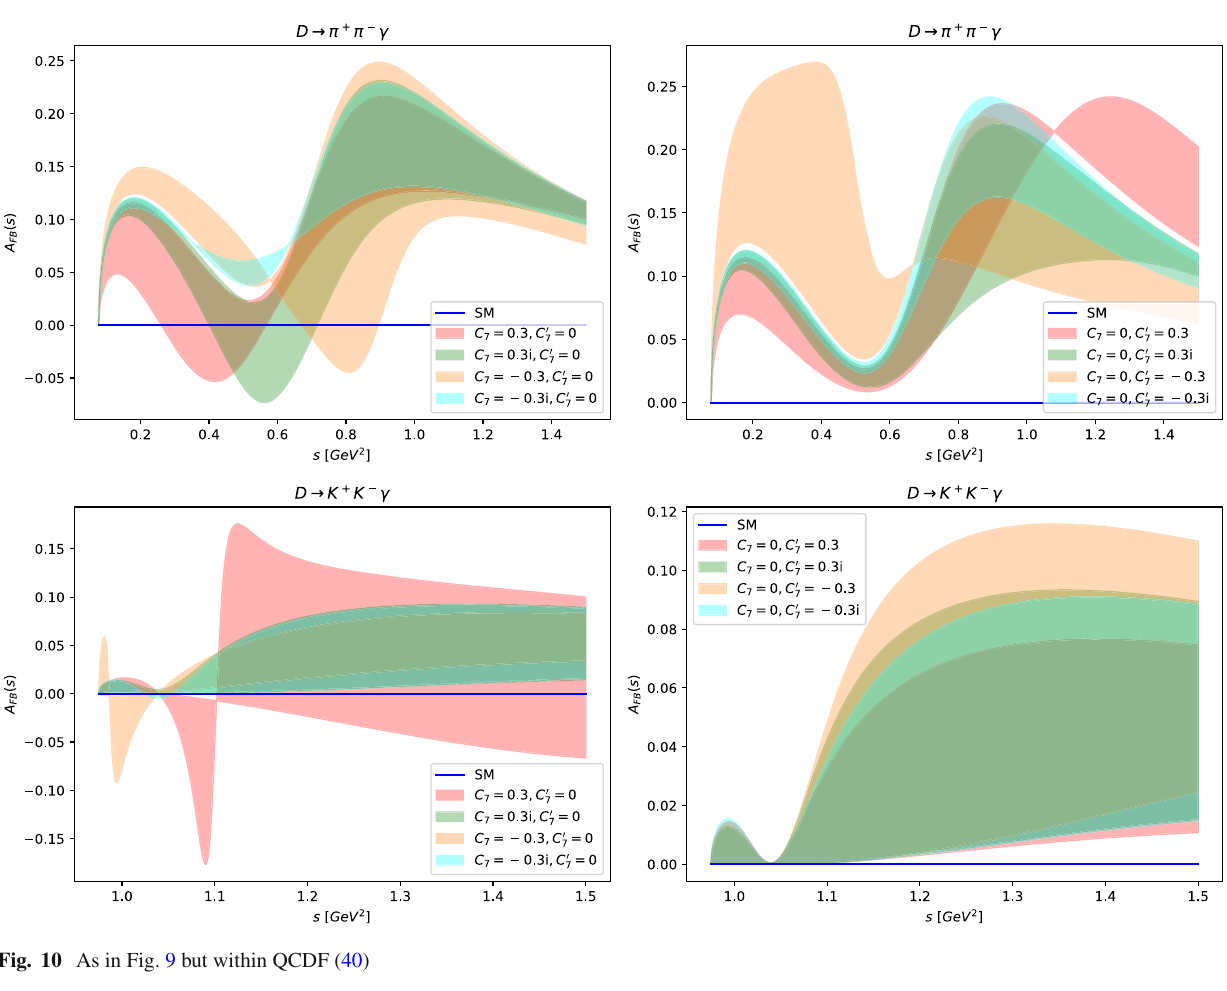
These values are in agreement with recent studies of D → π ll decays [38]. In Sect. 5.1 we discuss the implications of CP asymmetries in hadronic charm decays that can lead to constraints on the imaginary parts of the dipole opera-